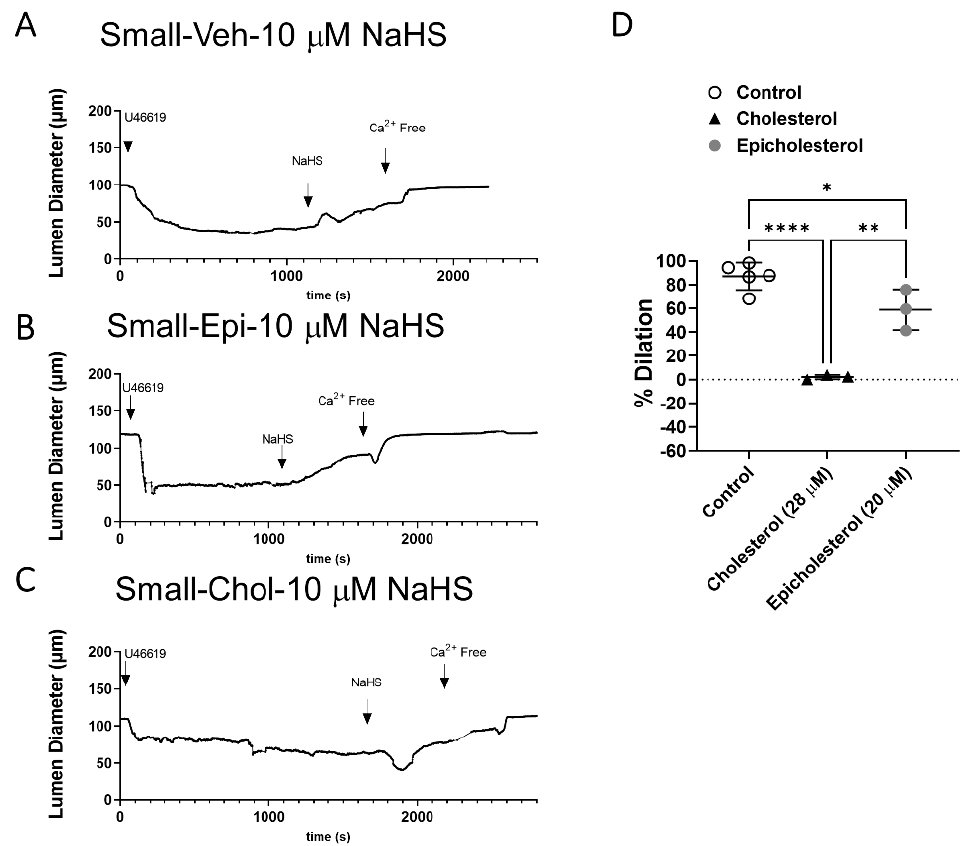
Figure 3. Representative traces and data summary of H 2 S-induced vasodilation under ( A ). vehicle (Veh) condition or following ( B ). epicholesterol (Epi, 20 µ M) or ( C ). cholesterol (Chol, 28 µ M) supple- mentation into EC PM of small mesenteric arteries. Summary data of H 2 S dilation in cholesterol and epicholesterol treated small arteries ( D ) Mean ± S.D. * p = 0.04, ** p = 0.0012, **** p < 0.001, one-way ANOVA with Sidak’s multiple comparison test.